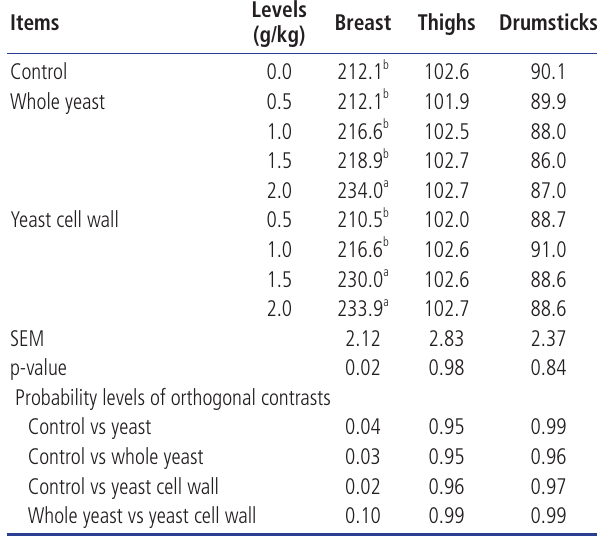
Table 8. Effect of dietary treatments on relative meat yield (g/kg) of broiler chickens at 35 d of